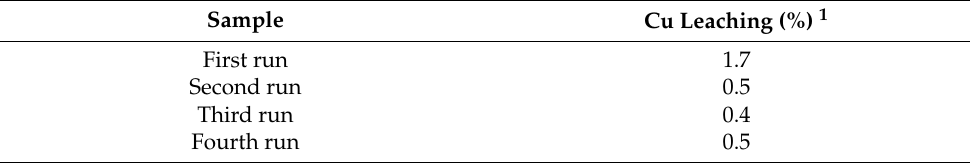
Figure 6. FE-SEM image of ( a ) Cu@N-C(600), and used Cu@N-C(600) ( b ) the first run, ( c ) the second run, and ( d ) the fourth run.